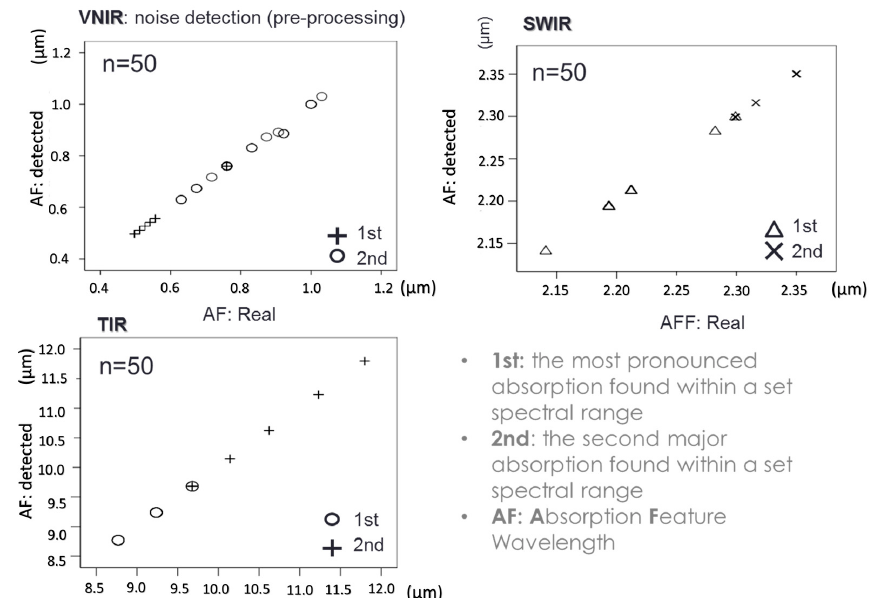
Figure 6. The manually derived absorption wavelength positions from 50 different image pixels of the HyMap and the AHS image data representing different material/surfaces compared to the absorption wavelength positions derived automatically when using QaunTools.